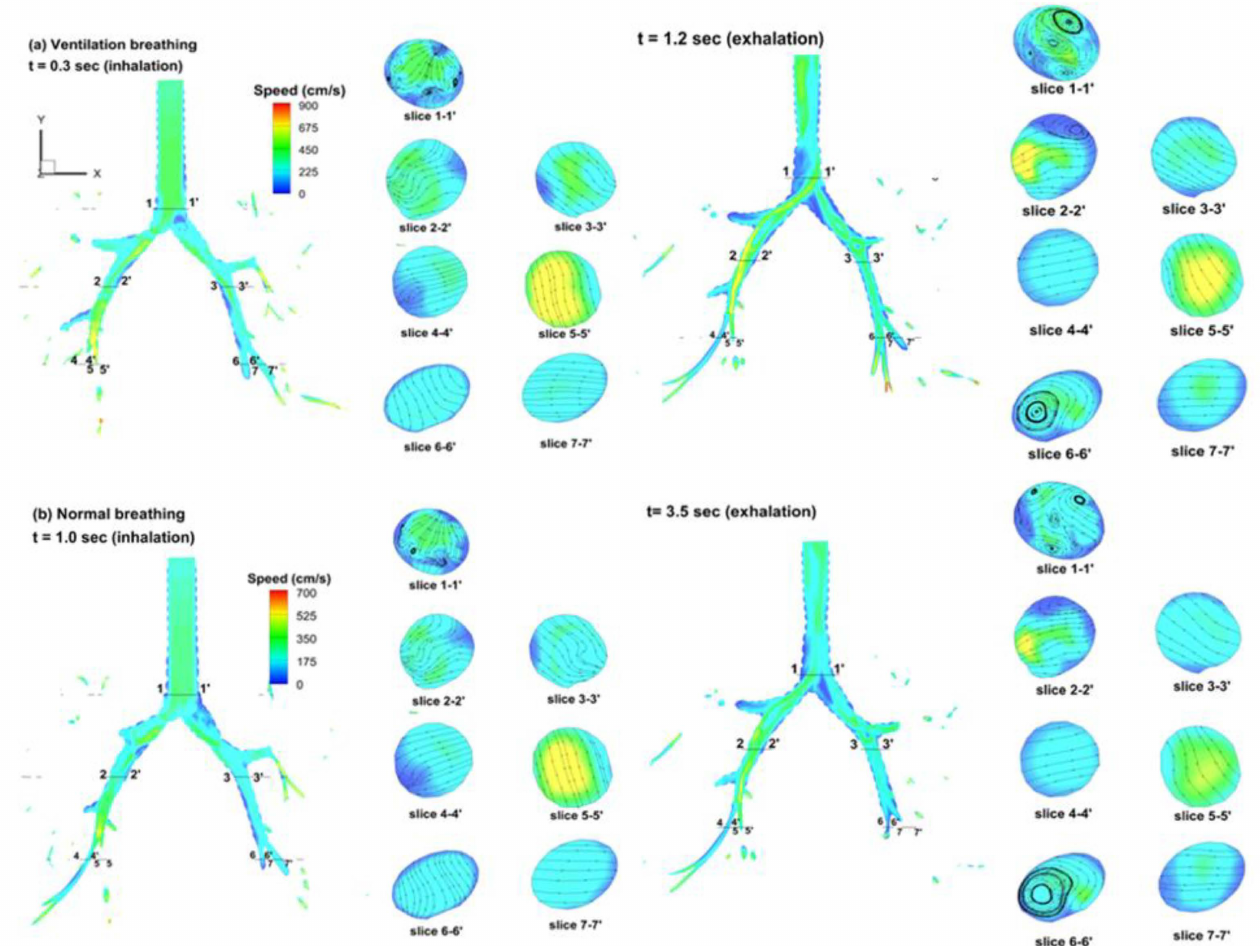
Figure 5. Comparison of velocity field using sagittal and cross-sectional view: instantaneous mid-plane contours of velocity magnitude, and in-plane streamlines of secondary motion in the trachea, left and right lung under transient conditions ( a ) t = 0.3 s, t = 1.0 s for mechanical ventilation, and ( b ) t = 0.9 s, t = 3.5 s for normal